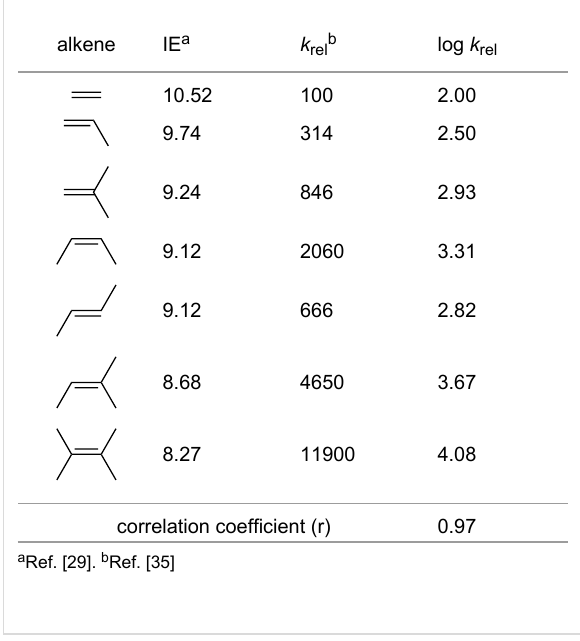
groupings are obtained in these plots for the two reactions; the scatter plot for areneselenenyl chloride addition to alkenes gives multiple lines (Figure 1), while arylsulfenyl chloride addition [89] gives a single trend line, both herein (Table 6, Figure 6, r all = 0.97) and previously [72] with a different set of relative rate data. Studies of other additions to alkenes which proceed through 3-membered rate-determining stationary points [72-78] have demonstrated that such different data point groupings reflect different steric and electronic characteristics of the